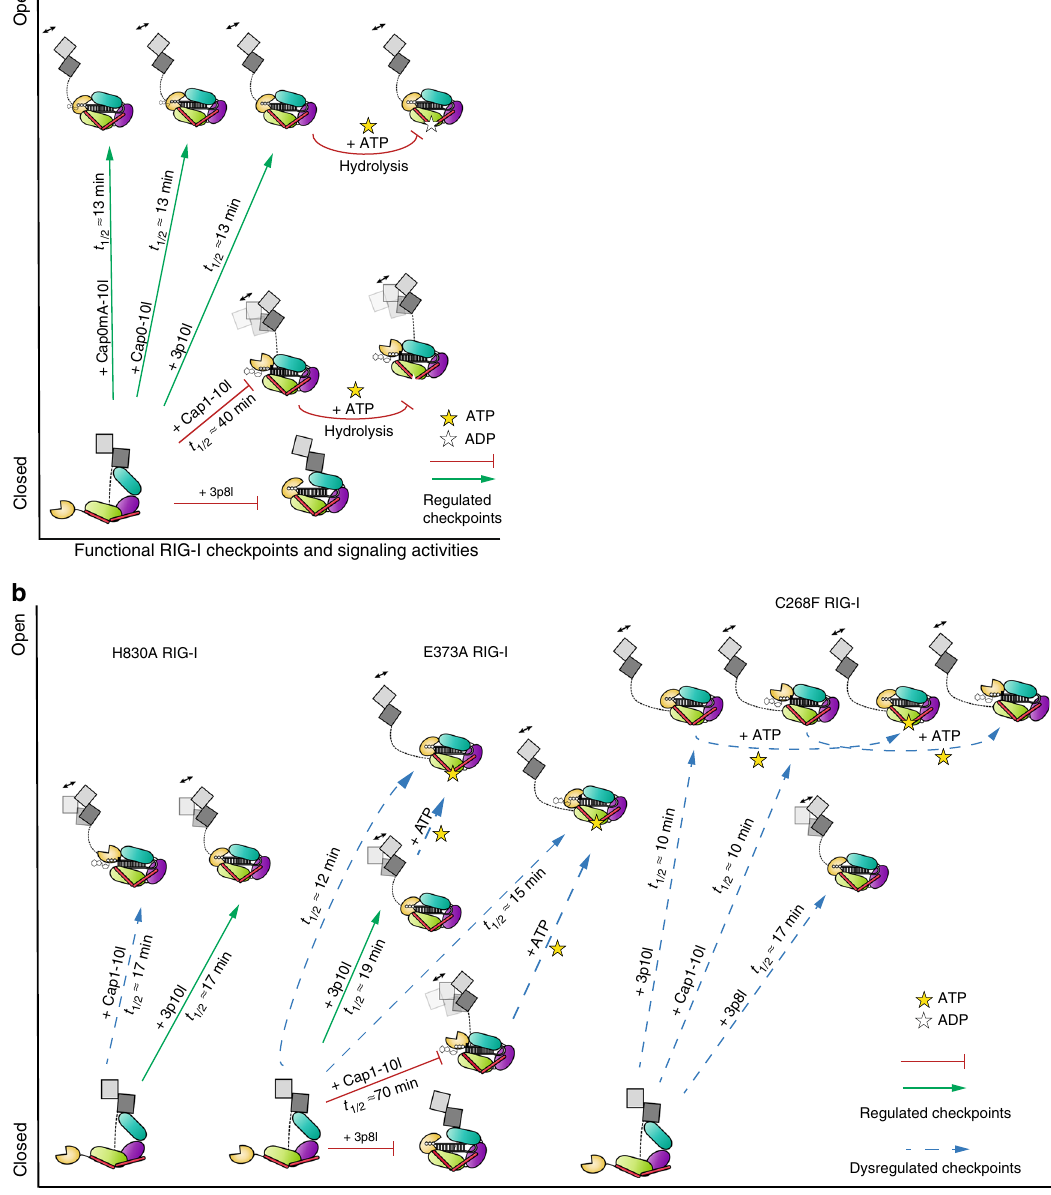
Fig. 5 Functional and dysregulated checkpoints of RIG-I proofreading. a Schematic representations of functional RIG-I checkpoints governing RIG-I CARDs conformational transition. b Schematic representations of aberrant CARDs conformational transition of RIG-I gain-of-function mutants revealed by comprehensive differential HDX analysis with quantitative analysis of CARDs EX1 exchange